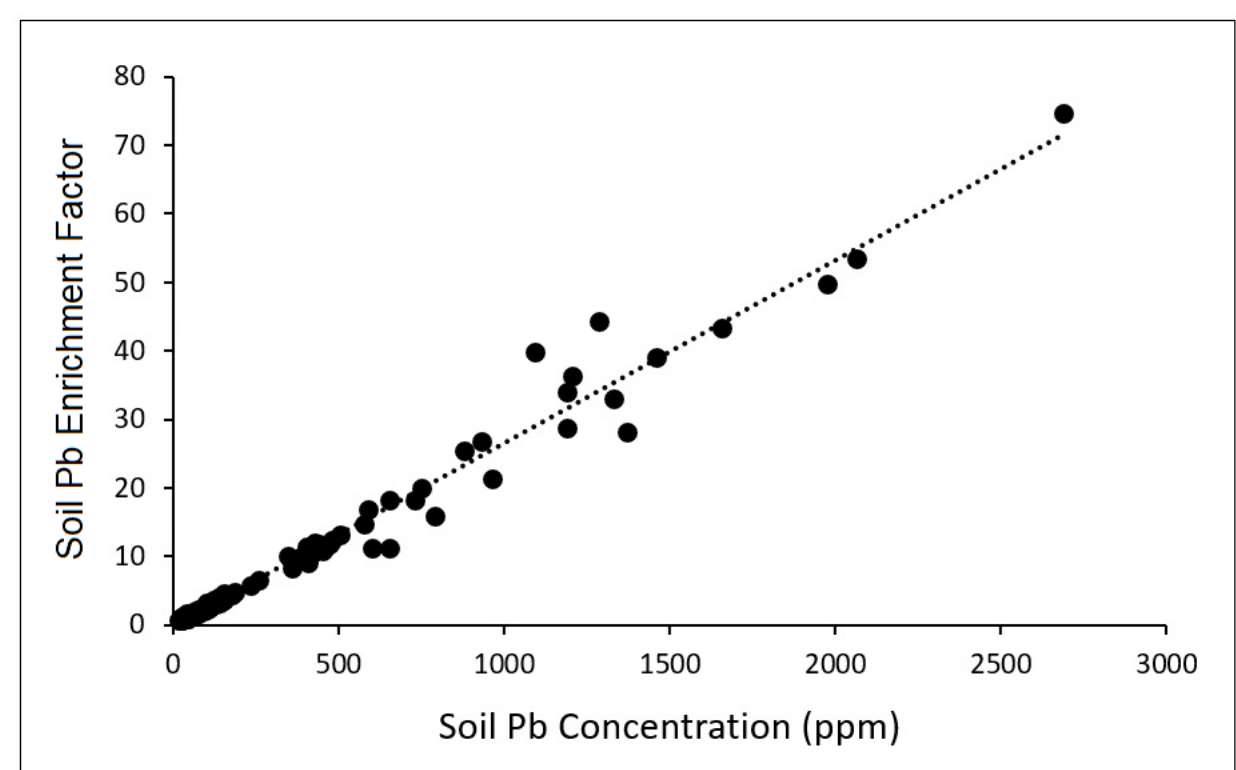
Figure 3. Scatter plot of soil enrichment factors and soil lead concentrations.